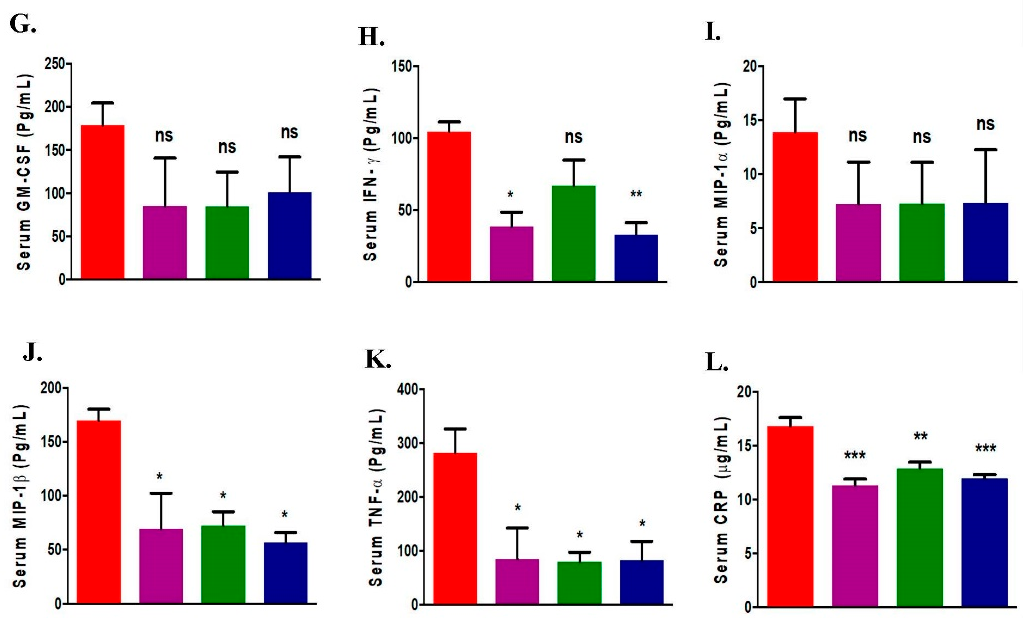
Figure 5. Effect of B. coagulans spores, PSCF and synbiotic on immune markers in serum. Protein levels of cytokines including ( A ) IL-1 α , ( B ) IL-1 β , ( C ) IL-6, ( D ) IL-10, ( E ) IL-12, ( F ) IL-17, ( G ) GM-CSF, ( H ) IFN- γ , ( I ) MIP-1 α and ( J ) MIP-1 β and ( K ) TNF- α in serum were analysed by Bio-plex. CRP levels in serum ( L ) measured by ELISA. Statistical significance among groups evaluated by one-way ANOVA. * p < 0.05, ** p < 0.01, *** p < 0.001, ns = non-significant vs. Winnie-control and data expressed as mean ± SEM ( n = 3 per group).